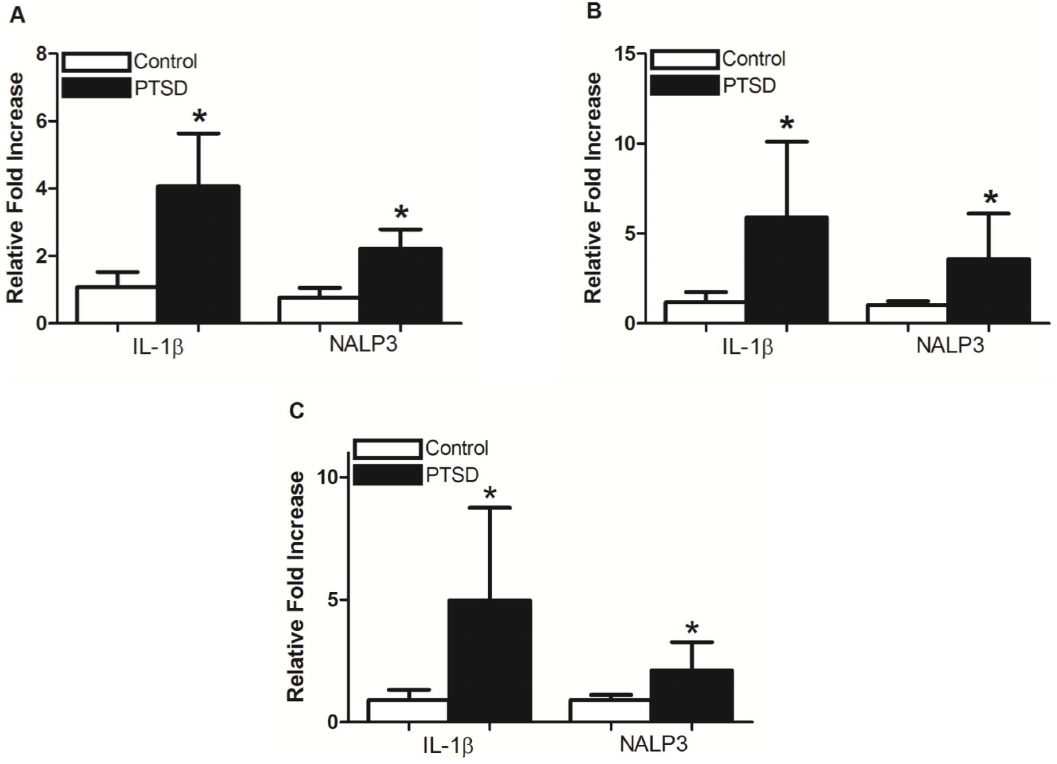
Figure 6. RT-PCR on the brain tissue. RT-PCR revealed IL-1 b and NALP3 mRNA were significantly elevated in the hippocampus (A), PFC (B), and amygdala (C) in the PTSD group. All data presented as mean 6 SEM. *p , 0.05 relative to the control group.